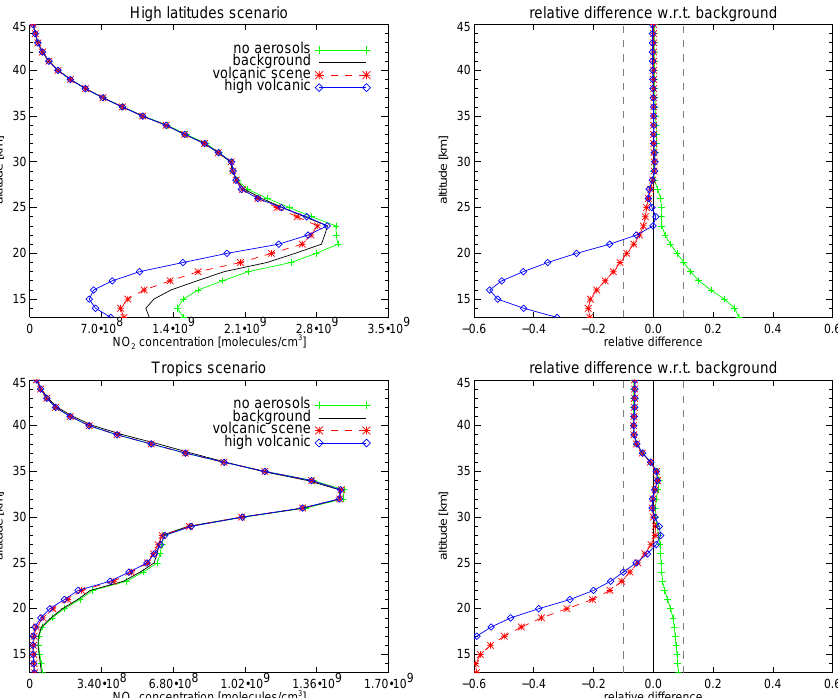
Fig. 3. Influence of the stratospheric aerosols on the retrieved NO 2 profiles. Left panels show NO 2 profiles retrieved for different aerosol loadings at northern high latitudes (upper panels) and in the tropics (lower panels), 18 June 2005. Right panels show corresponding relative